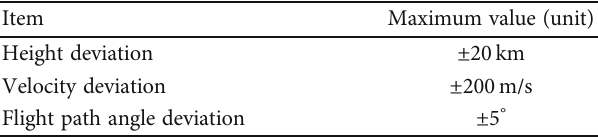
Table 2: List of initial state